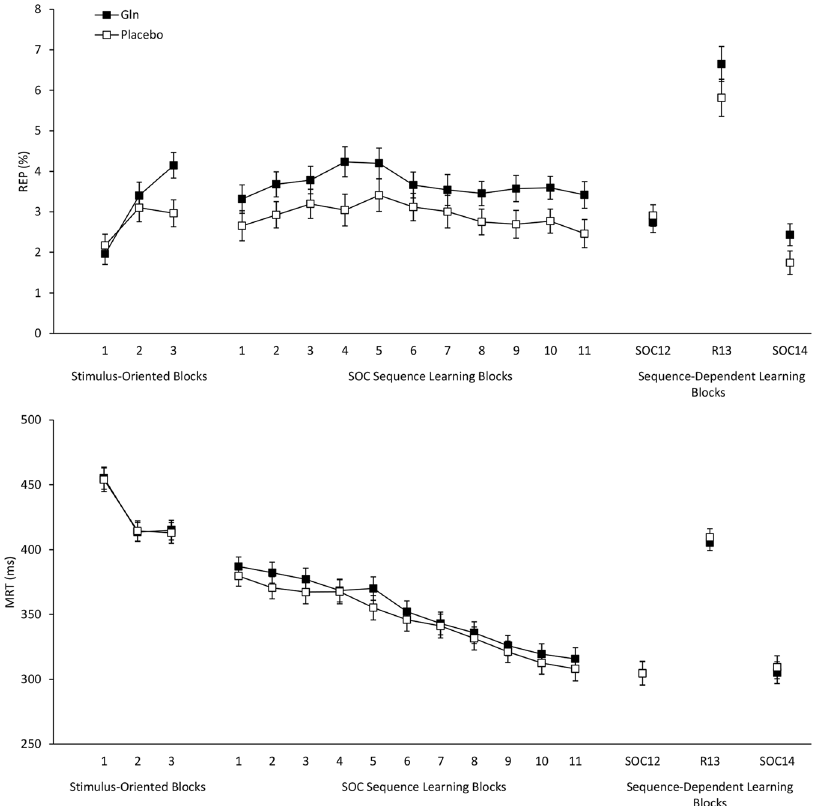
Figure 1. Mean REP (top panel) and MRT (bottom panel) as a function of block and group (Gln vs. placebo). ‘SOC’ refers to an SOC sequence block and ‘R’ refers to a random sequence block. Bars represent standard error of the